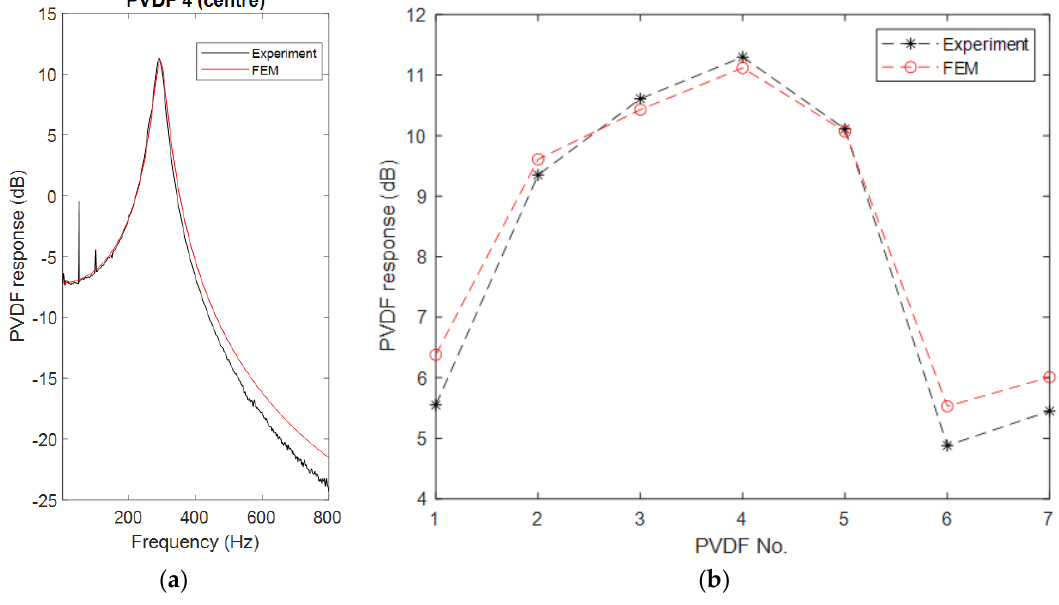
Figure 8. Comparison of PVDF outputs between experiment and FE model: ( a ) frequency response of PVDF 4 and ( b ) the output distribution of the PVDF array at 290 Hz.